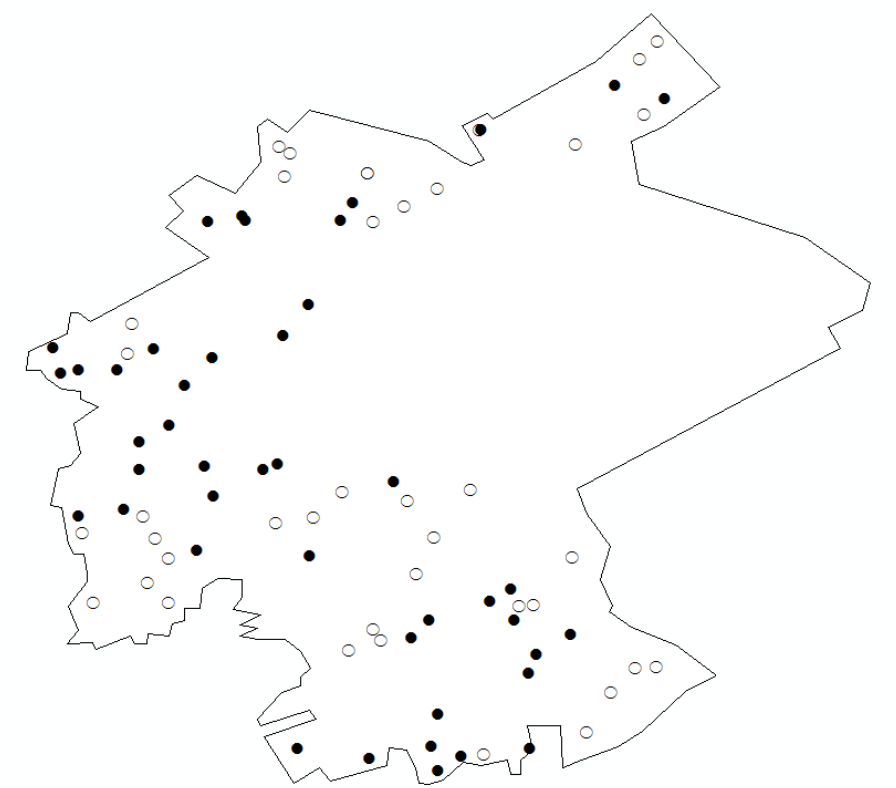
Figure 4. Distribution of Cd